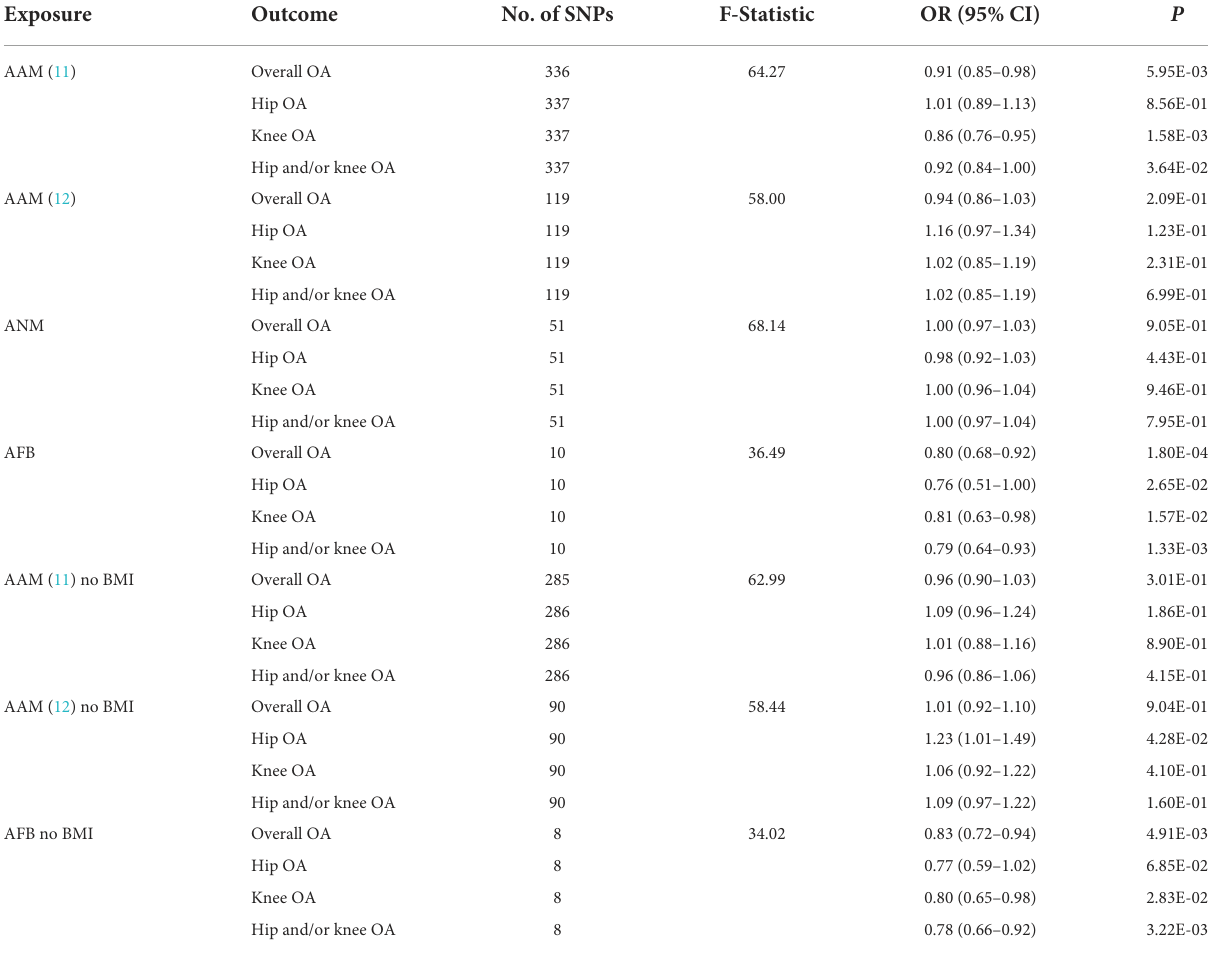
TABLE 1 Univariable MR results of hormonal reproductive factors on risk of OA and subtypes.